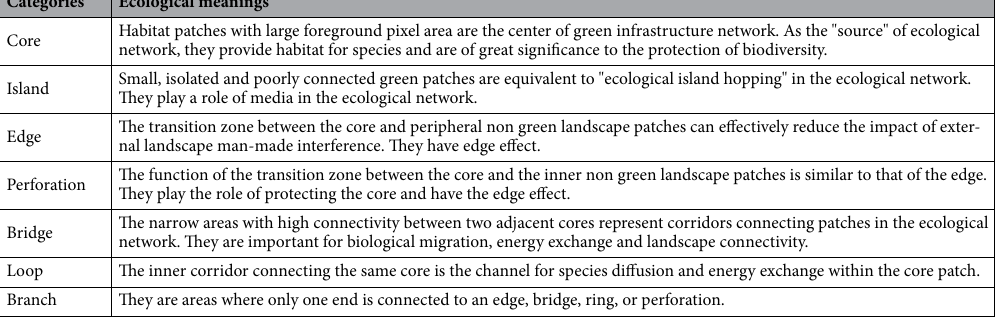
Table 4. Categories and ecological meanings of UGI 61